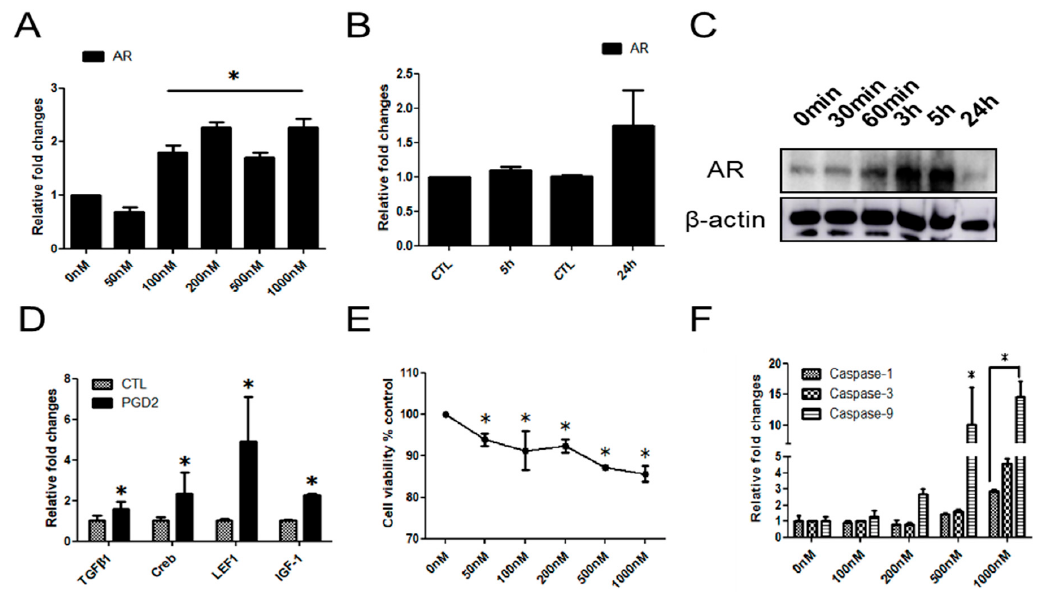
Figure 2. PGD2 regulates the AR expression and viability of hDPCs. hDPCs were cultured in serum-free DMEM for 24 h, and then treated with the indicated concentrations of PGD2 for 24 h ( A ). For optimal condition of AR mRNA expression, hDPCs were cultured in serum-free DMEM for 24 h, and then 200 nM PGD2 treated in hDPCs for 5 and 24 h ( B ). hDPCs were treated with PGD2 (200 nM) for the indicated times and harvested. The AR protein level was determined using western blot analysis ( C ). The mRNA expression of transforming growth factor beta 1 (TGF β 1), Creb, lymphoid enhancer binding factor 1 (LEF1) and insulin-like growth factor 1 (IGF-1) was measured by qRT-PCR ( D ). Cell viability was determined using 3-(4,5-dimethylthiazol-2-yl)-2,5-diphenyl-2-H-tetrazolium bromide (MTT) assay after incubation with different concentrations of PGD2 (0, 50, 100, 200, 500, 1000 nM) for 72 h ( E ). The mRNA expression of caspase-1, -3, and -9 was measured by qRT-PCR ( F ). The results are expressed as the mean ± SD of three independent experiments. * p < 0.05, compared with the control (0 nM PGD2).